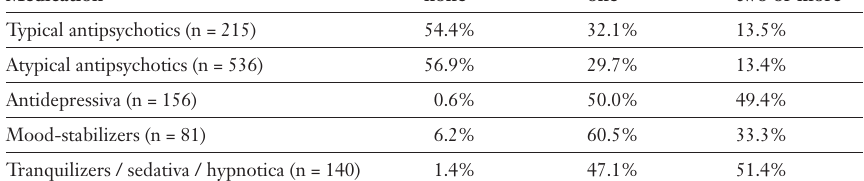
Comedication (num- ber of medications of other classes).